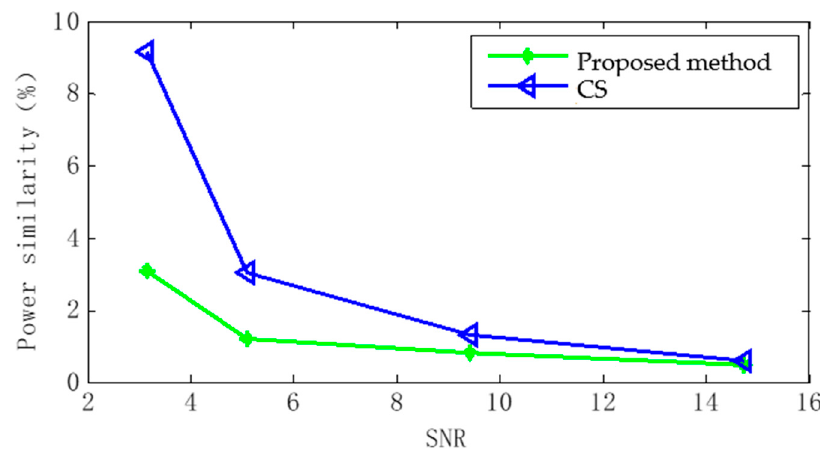
Figure 10 Figure 10. Comparison of power spectrum similarity under different